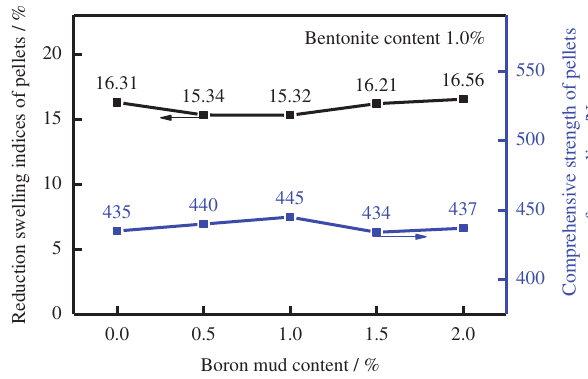
Figure 3: Effects of boron mud on reduction swellability of